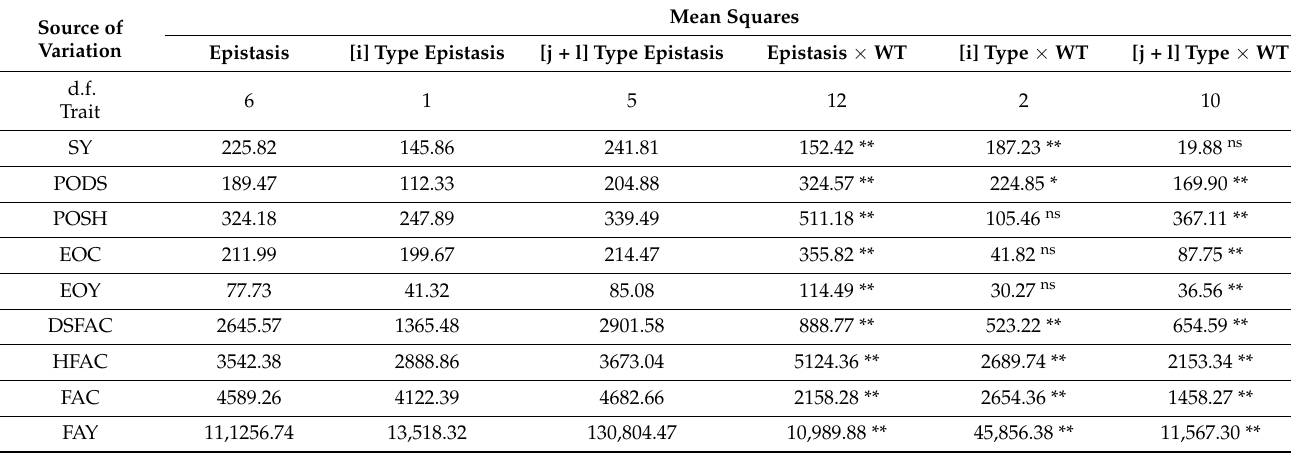
Table 3. Analysis of variance for total, [i] type, and [j + l] type epistasis and their interactions with water treatments (WT) for different traits in coriander. Source of Variation